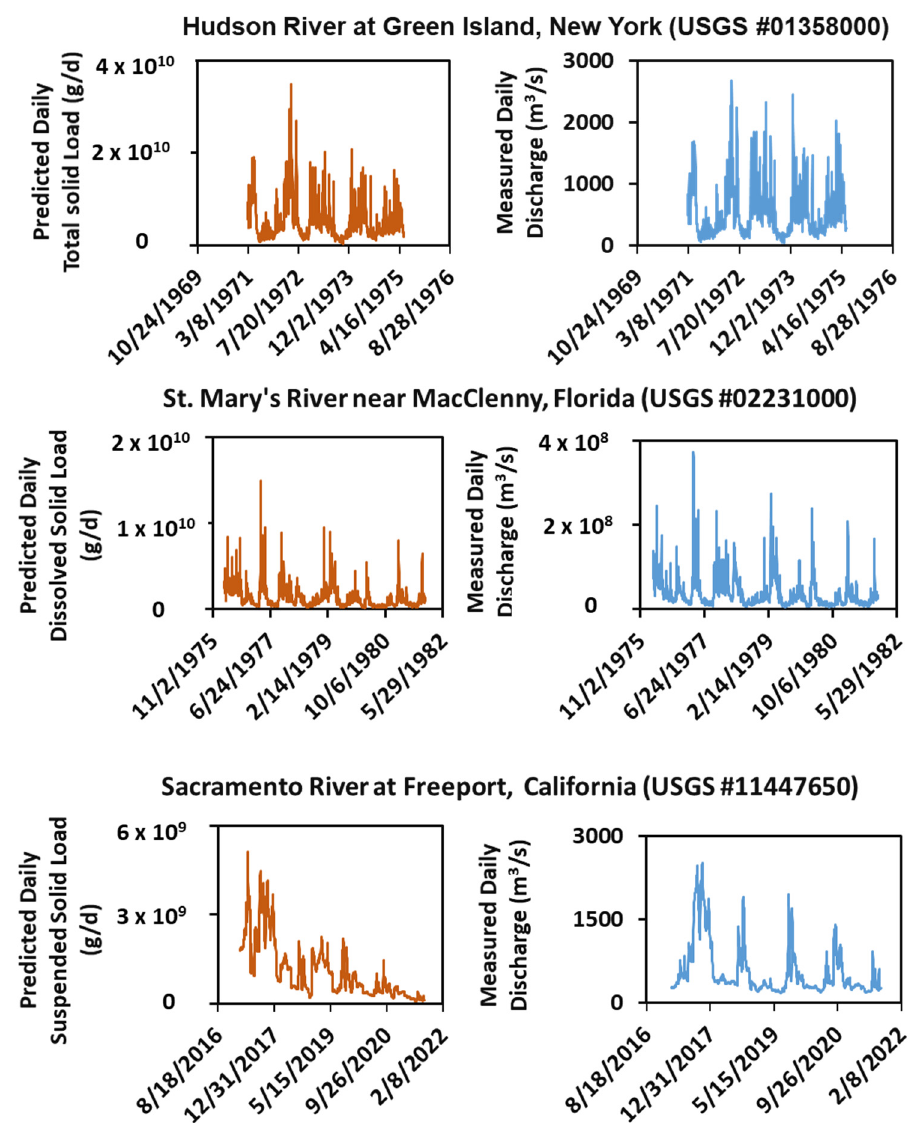
Figure 6. Predicted daily sediment loads and their corresponding measured daily discharges for